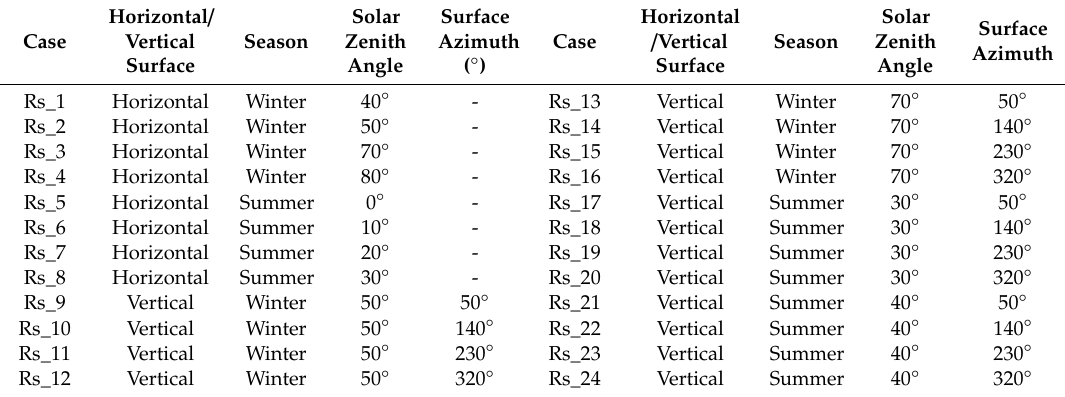
Table 2. The conditions used while simulating solar spectral